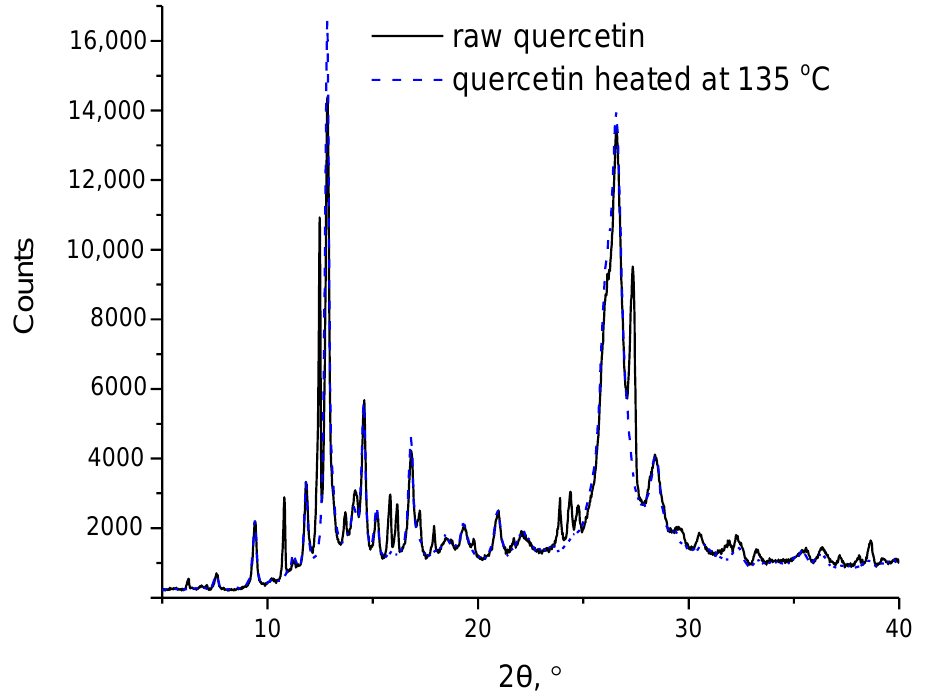
Figure 4. XRD patterns of raw quercetin and quercetin heated at 135 °C.